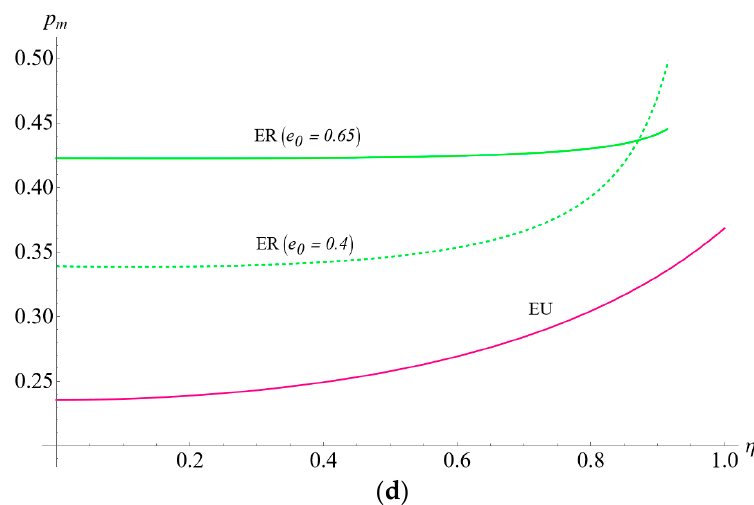
Figure 4. ( a ) The impact of η and e 0 on the optimal carbon emission levels. ( b ) The impact of η and e 0 on the optimal wholesale price. ( c ) The impact of η and e 0 on the NB product price. ( d ) The impact of η and e 0 on the FB product